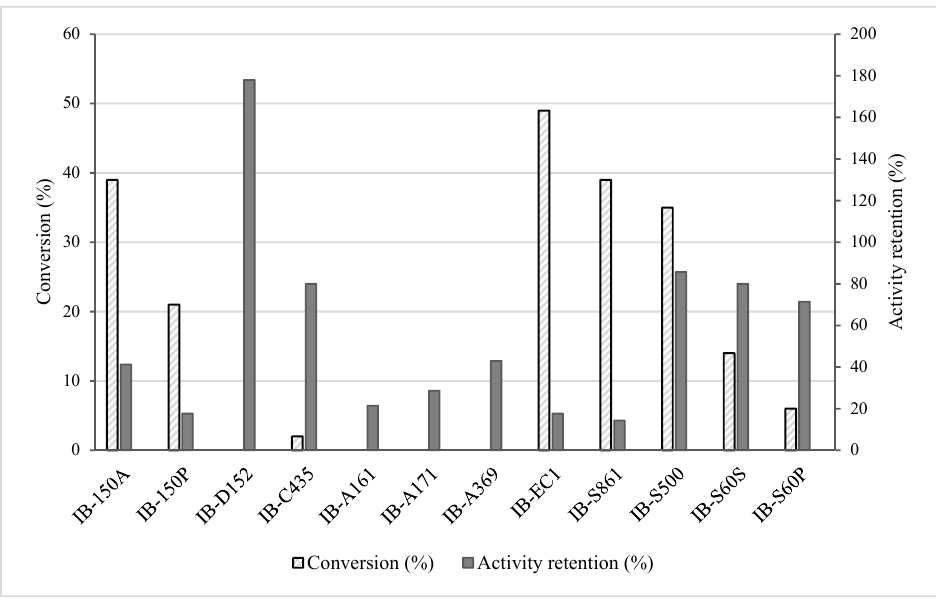
Figure 3. The catalytic activity of immobilized CALB. Activity retention (%) in buffer medium-hydrolysis of olive oil; conversion (%) in DCM–esterification of ( R , S )-flurbiprofen with methanol; values of conversion and activity retention from Tables 2 and 6, respectively.